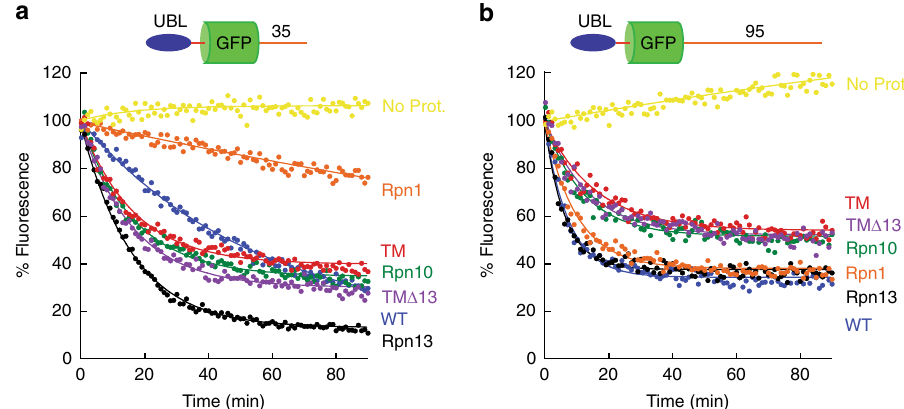
Fig. 8 Degradation of UBL-targeted substrates. Degradation of substrate proteins with ubiquitin-like domains derived from Rad23 (UBL) by the indicated proteasome types was followed under single-turnover conditions (5 nM substrate, 25 nM proteasome) in the presence of 1 mM ATP at 30 °C. The graphs show substrate fl uorescence as a percentage of the initial fl uorescence as a function of time in minutes. Proteasome types are described in Supplementary Table 1 (TM triple mutant proteasome). Each panel shows the degradation of particular substrates, and as follows: a UBL-GFP-35 and b UBL-GFP-95 on different proteasome mutants. Source data are provided as a Source Data fi